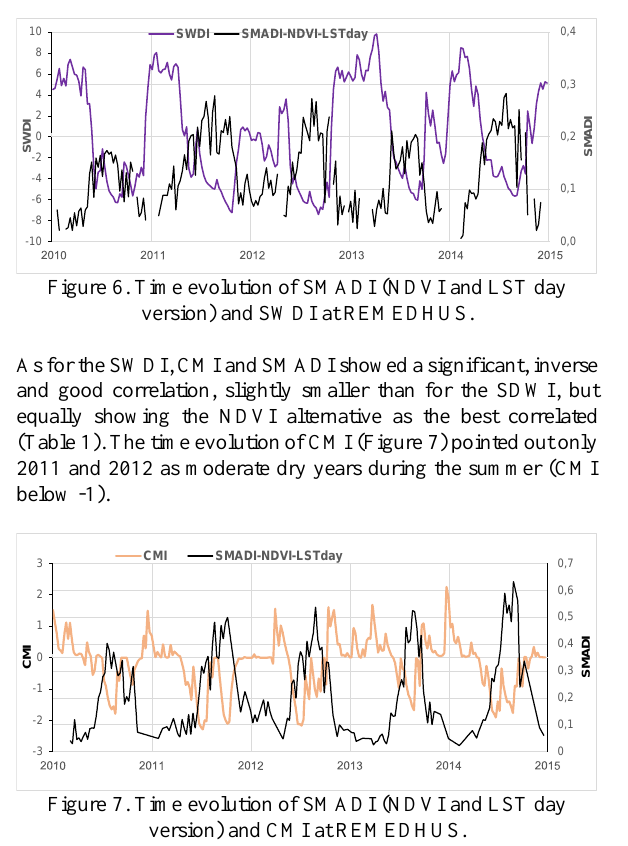
Table 1. Pearson coefficient (R) between SWDI, CMI and SMADI for the REMEDHUS area average. All the correlations have a p-value<0.01.